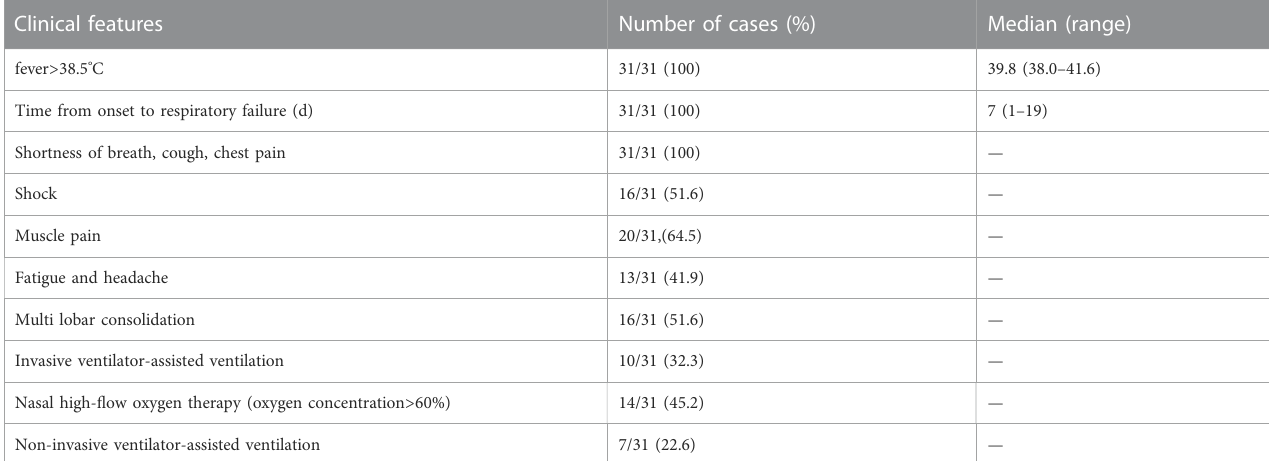
TABLE 2 Clinical characteristics of patients with C. psittaci pneumonia.